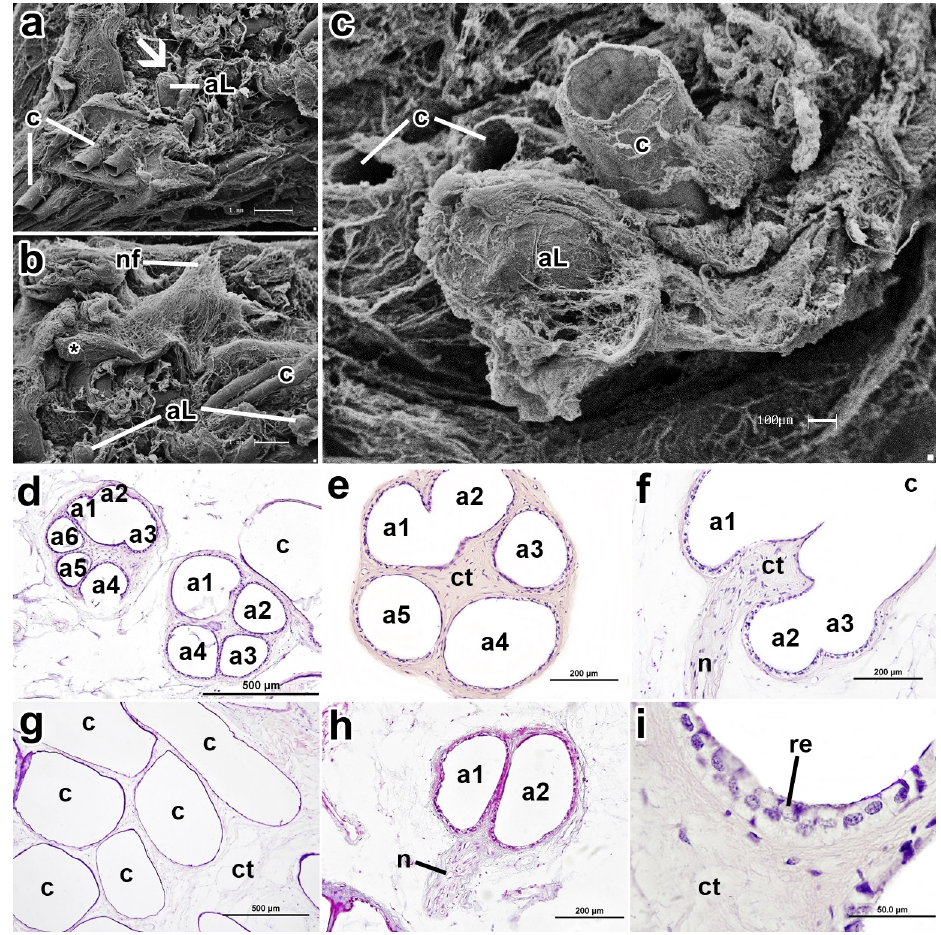
Figure 2 - Hyoid cluster microscopy . ( a, b and c ) disposition and parallel of input canals (c) and location of the ampullae of Lorenzini (aL) in the hyoid cluster; (*) capsule coating the hyoid cluster. ( d, e and f ) in HE staining the vials in cross section, covered with connective tissue (ct), with up to six alveoli (a1-a6) and canal (c). ( g ) canals at random in sagittal and transverse sections, separated by connective tissue (ct). ( h ) in TM staining, ampullae in sagittal section with visible nerve (n) ( i ) in HE staining the receptor epithelium (re) in largest magnification formed by cubic cells and oval nucleus. Scale bars: ( a ) 500 μm; ( b - f ) 200μm; ( g ) 100μm; ( h and i )